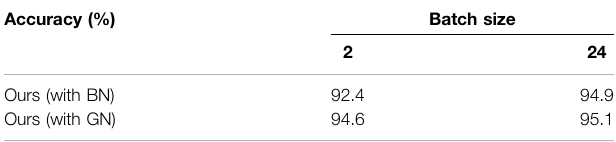
TABLE 3 | Classi fi cation accuracy when computing power is enough or not